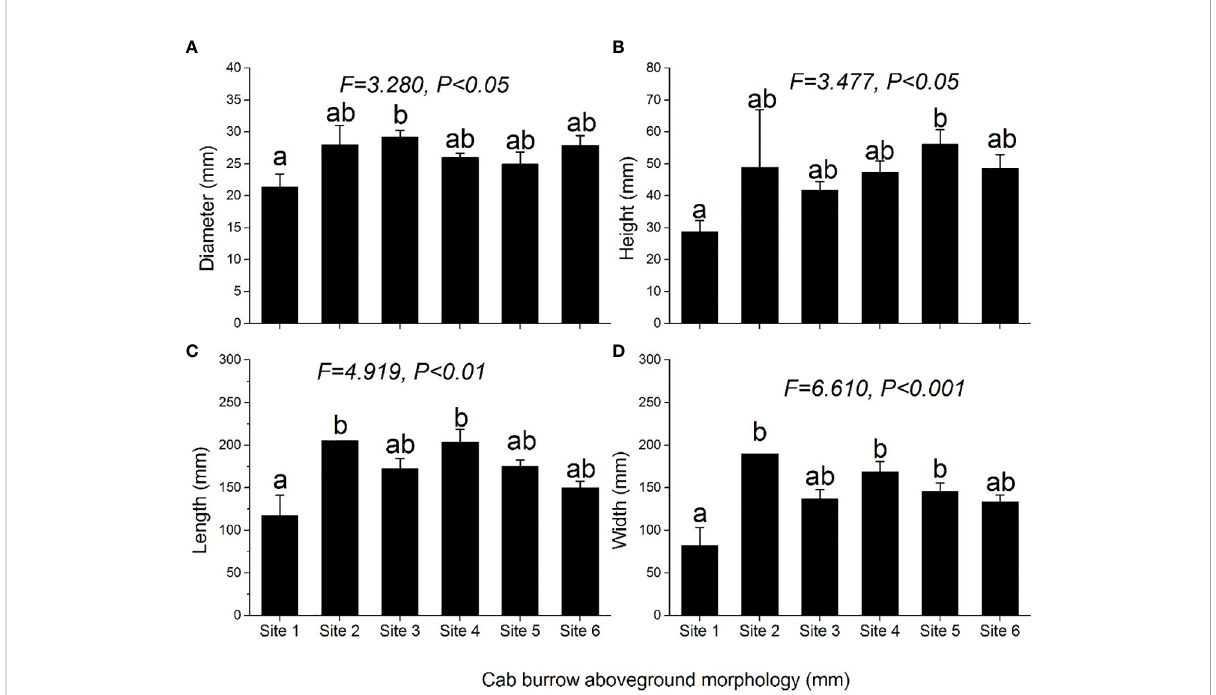
FIGURE 6 Morphological characteristics: (A) diameter, (B) height, (C) length, and (D) width of crab burrow aboveground mounds at each site. Data are shown as means ± SE. Letters indicate signi fi cant differences with a Tukey